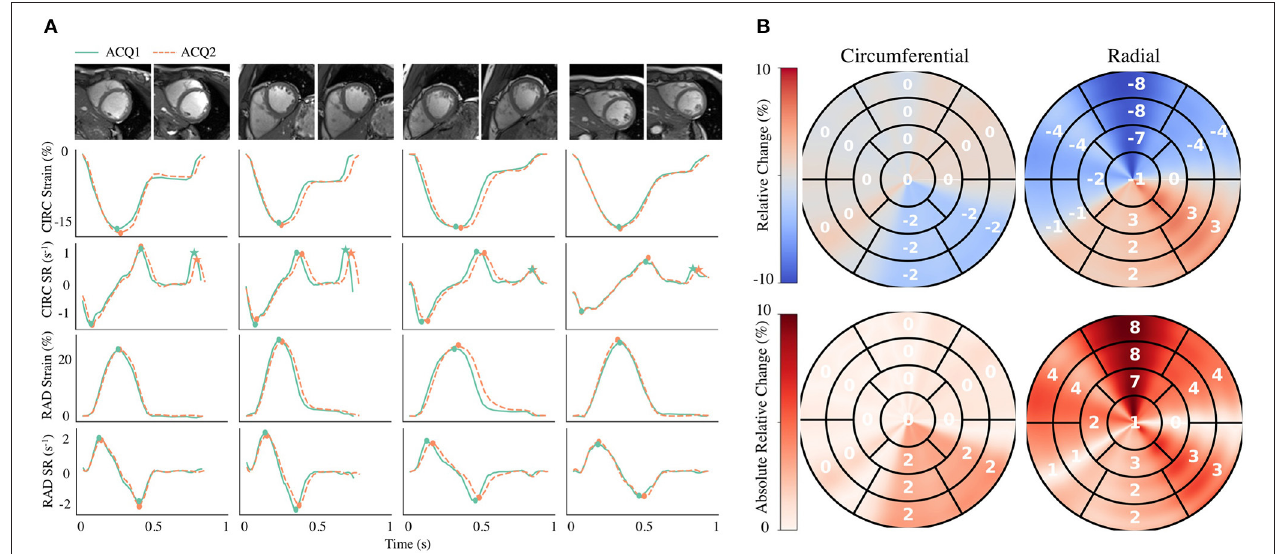
FIGURE 6 | Intra-scanner repeatability of global and regional myocardial strain measures on the MARTINOS dataset. (A) Circumferential (CIRC) and radial (RAD) strain and strain rate (SR) curves across time derived from two different acquisitions (ACQ). Four representative healthy subjects are shown, including the correspond cine images used for analyses. (B) Polar maps for all subjects were used to evaluate the relative change and absolute relative change across polar map segments. Circles represent peak systolic and early-diastolic strain values. Stars represent peak late-diastolic strain values. TABLE 3 | Intra-scanner repeatability of global circumferential and radial end-systolic strain (ESS) measures.